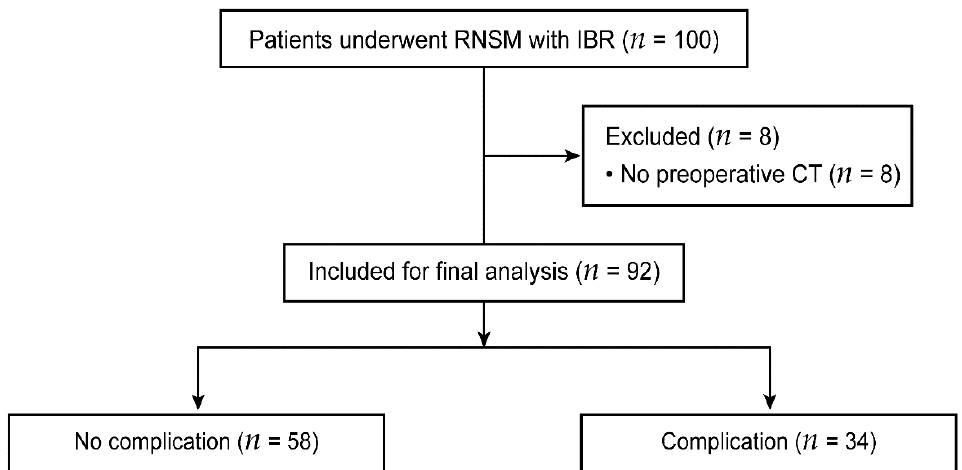
Figure 1. Consolidated standards of reporting trials flow diagram. RNSM, robotic nipple-sparing mastectomy; IBR, immediate breast reconstruction; and CT, computed tomography .